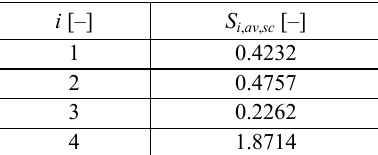
Table 3. The average sensitivity of the neural network for the i -th input parameter